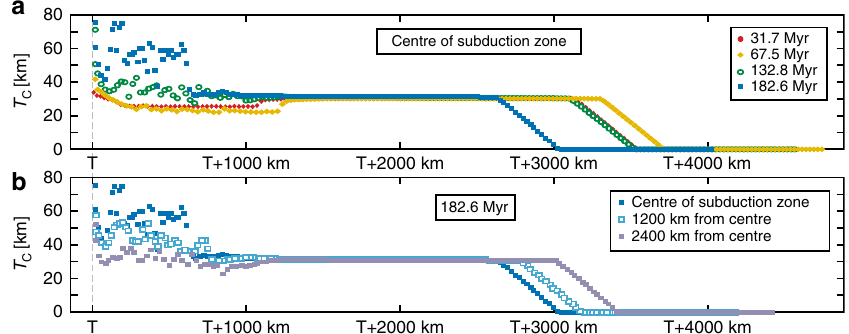
Fig. 8 Numerical results showing the temporal evolution and lateral variation of the continental crustal thickness in the overriding plate. a Overriding plate crustal thickness ( T C ) at four different times (31.7 Myr corresponding to the Middle Jurassic in nature, 67.5 Myr corresponding to the Early Cretaceous, 132.8 Myr corresponding to the latest Cretaceous, 182.6 Myr corresponding to the Late Cenozoic) in the centre of the subduction zone. b Overriding plate crustal thickness at three different sections along the subduction zone (centre of the wide subduction zone, 1200 km from the centre and 2400 km from the centre) in a late stage of the subduction evolution (182.6Myr, corresponding to the Late Cenozoic). Note that the original continental crustal thickness (at model time = 0 Myr) is 30 km, and that changes in thickness are due to overriding plate shortening